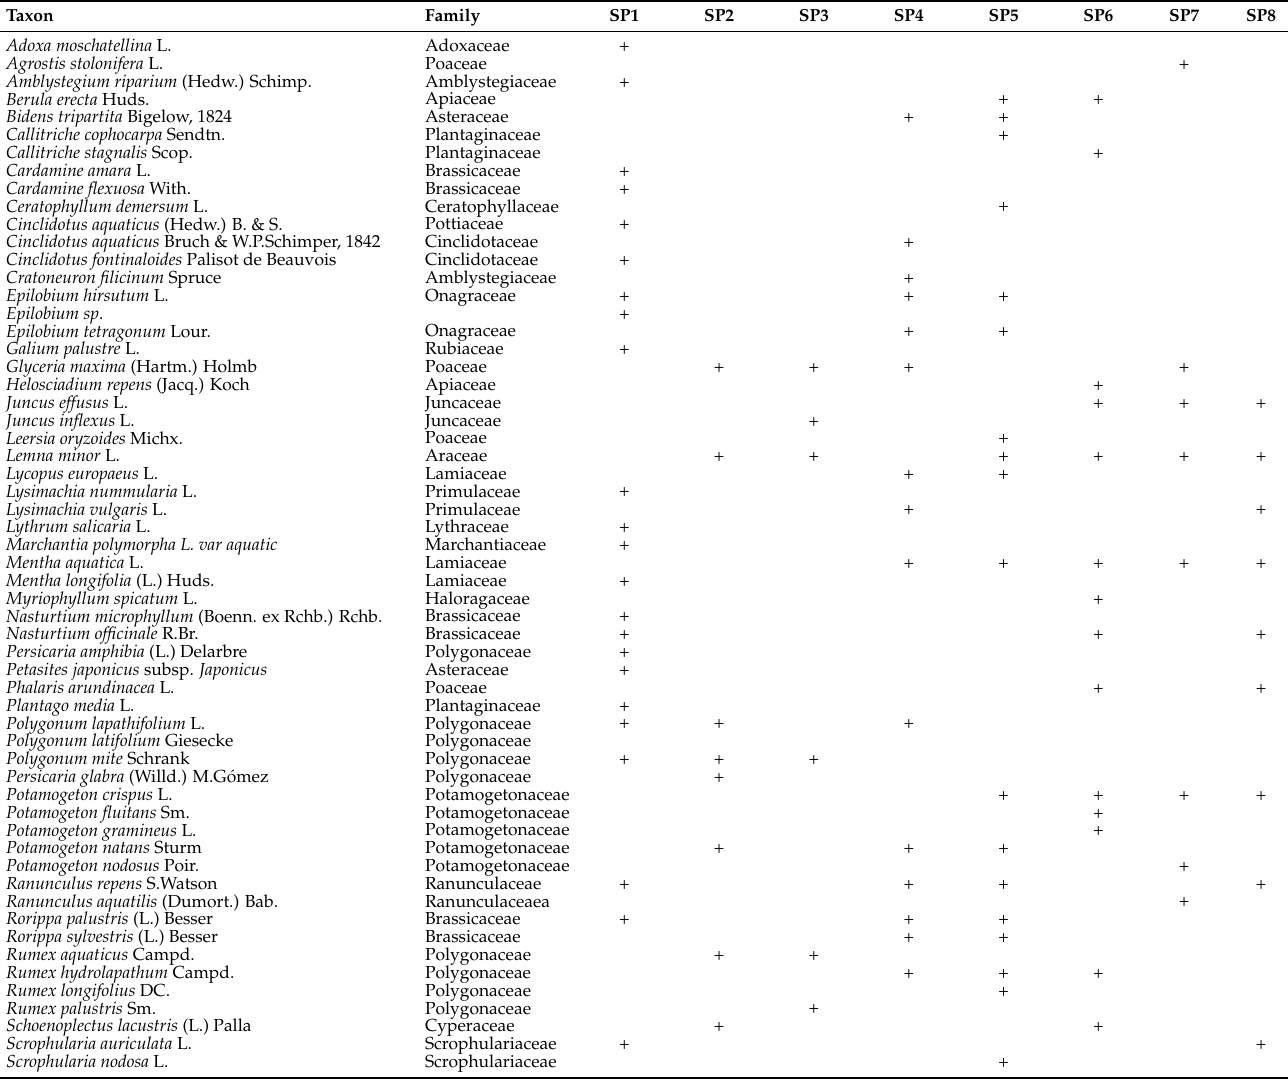
Table 5. List of plants and index